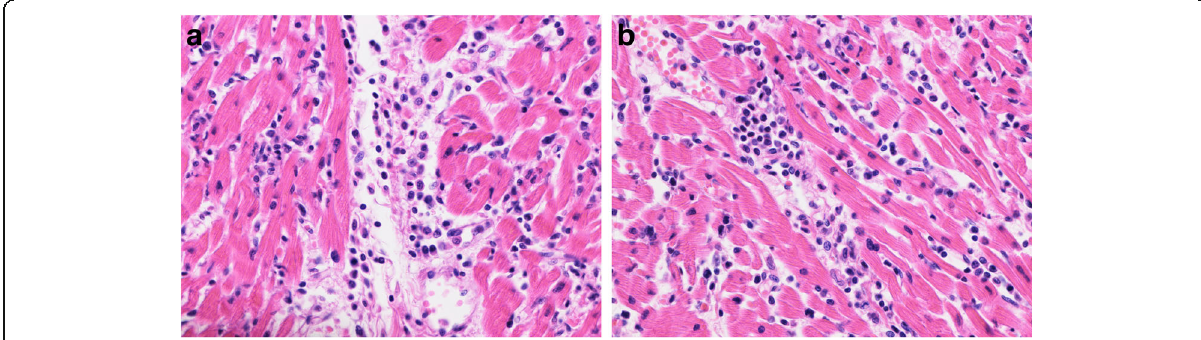
Fig. 1 Histopathological findings of the left ventricle in case 1 ( a ) and case 2 ( b ). In myocardial cells of both cases, myocardial cells with minor necrosis and degeneration were observed sometimes in tissue sections, with a lot of lymphocytic infiltration and a few areas of neutrophilic infiltration in the interstitial spaces (magnification, ×